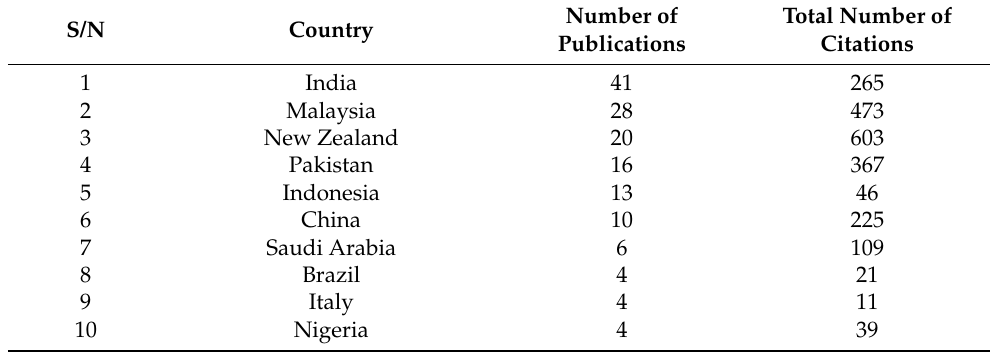
Table 5. Leading countries based on published documents in the present research area until